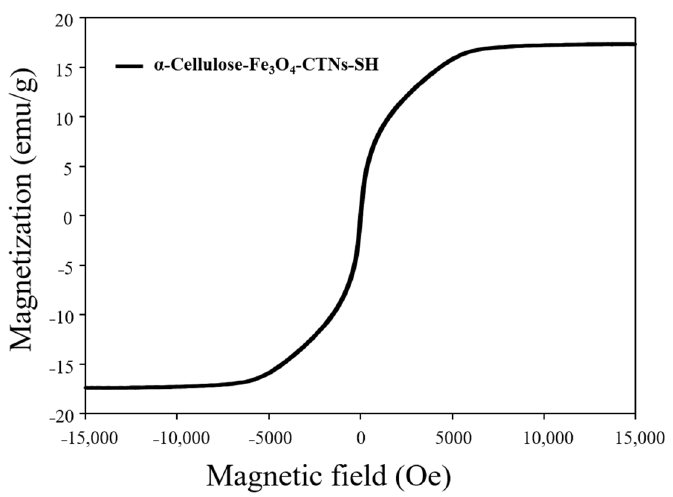
Figure 4. Vibrating sample magnetometer (VSM) analysis of the α -Cellulose-Fe 3 O 4 -CTNs-SH.